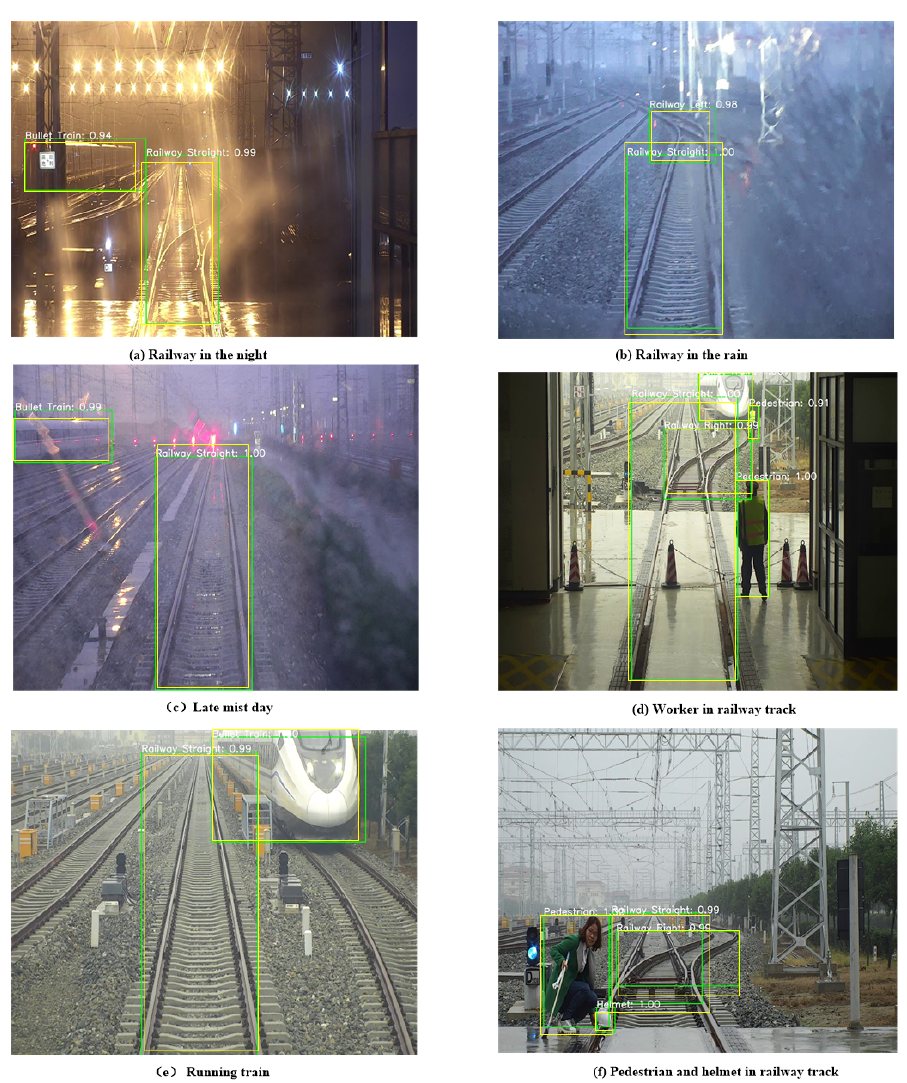
Figure 9. Robustness test in different environmental conditions.